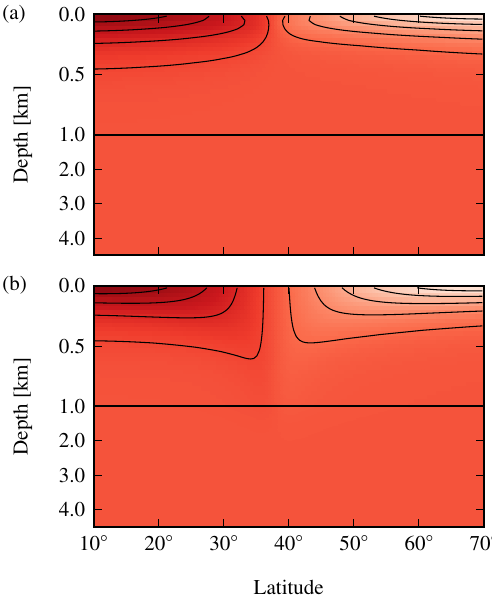
Fig. 11. Buoyancy fields for the nonconvective case: (a) western- boundary buoyancy b w (contour interval 0 . 5 × 10 − 2 ms − 2 ) and (b) eastern-boundary buoyancy b e (contour interval 0 . 5 × 10 − 2 ms − 2